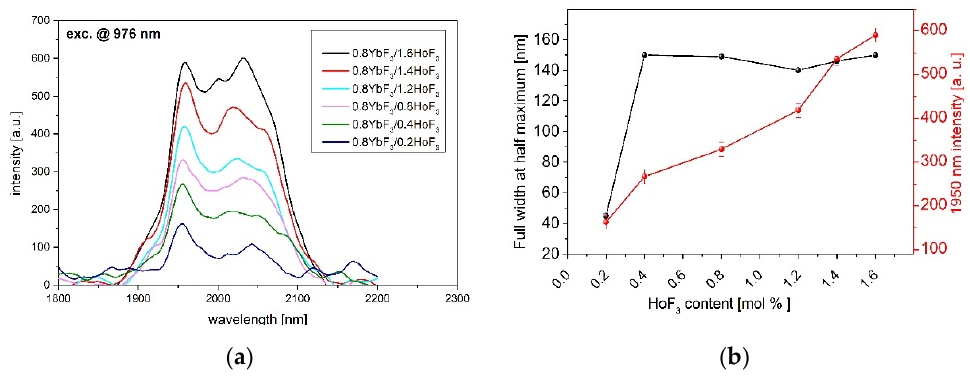
Figure 2. ( a ) Near- infrared (IR) luminescence spectra and ( b ) FWHM (Full With at Half Maximum), 1950 nm intensity of 0.8YbF 3 /(0.2–1.6)HoF 3 co-doped fluoroindate glasses, λ exc = 976